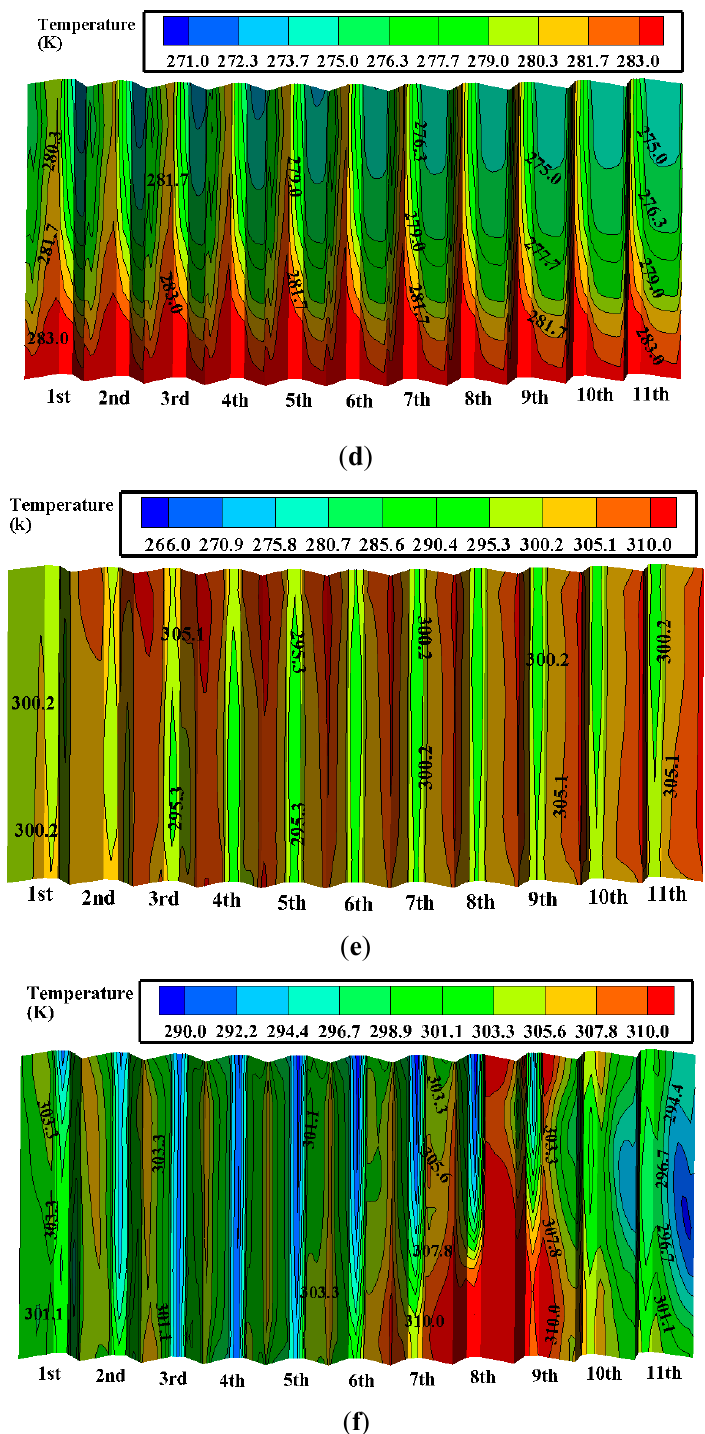
Figure 12. Variable fields of the middle deltas. ( a ) Pressure and flow fields at 4 m/s, ( b ) pressure and flow fields at 12 m/s, ( c ) pressure and flow fields at 16 m/s, ( d ) outlet air temperature at 4 m/s, ( e ) outlet air temperature at 12 m/s, ( f ) outlet air temperature at 16 m/s. For the middle-rear deltas, it can be seen from Figure 14a that the air changed from a perpendicular direction to flow through the finned tube bundles at a small wind speed of 4 m/s, due to the recovered pressure differences. In contrast, at a high wind speed of 12 m/s, air flow penetration appeared for the first to the seventh deltas, resulting from the reversed pressure difference between the inlets